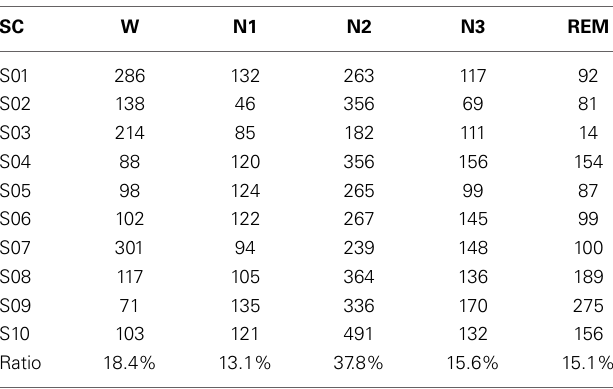
Table 1 | Distribution of sleep stages for each